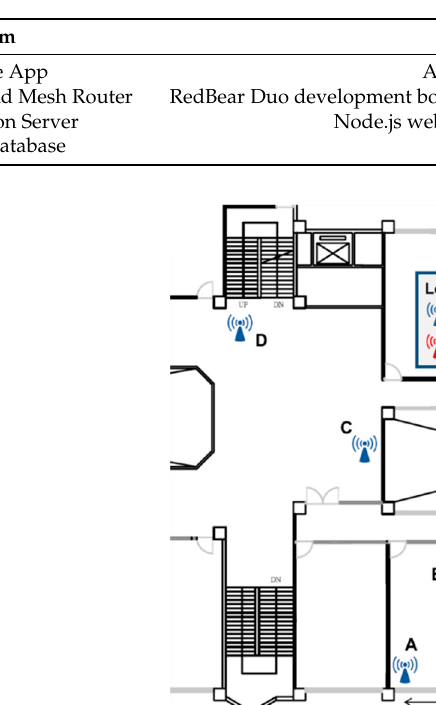
Table 1. Hardware and software used in our prototype system.